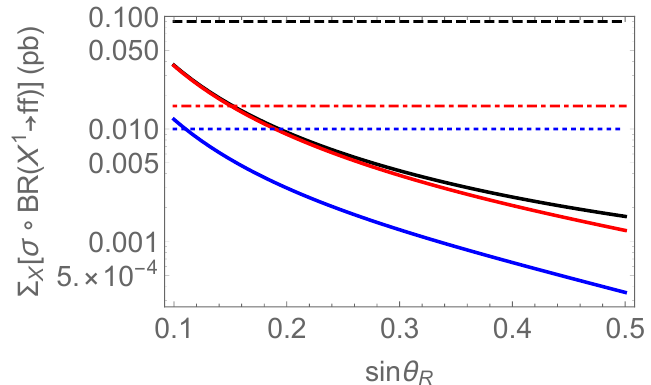
Figure 6 . Plot of P (cid:27) (cid:2) B ( X 1 ! (cid:22) ff ) as a function of sin (cid:18) R , for m 1 = 3 TeV and f = b R (upper X black solid line), f = t R (middle red solid line) and f = (cid:28) R (lower blue solid line). Horizontal lines correspond to the 95% CL experimental upper bounds from the ATLAS experiment for f = b R (upper dashed line), for f = t R (middle dot-dashed red line) and f = (cid:28) R (lower dotted blue